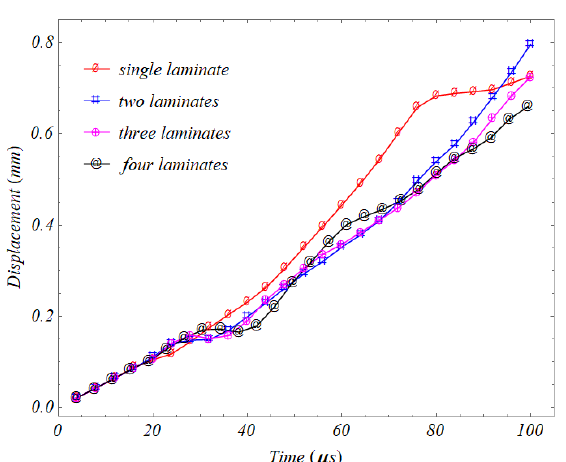
Fig. 27. Displacement against time for various number of cellphone casing laminates at 1500mm drop distance.